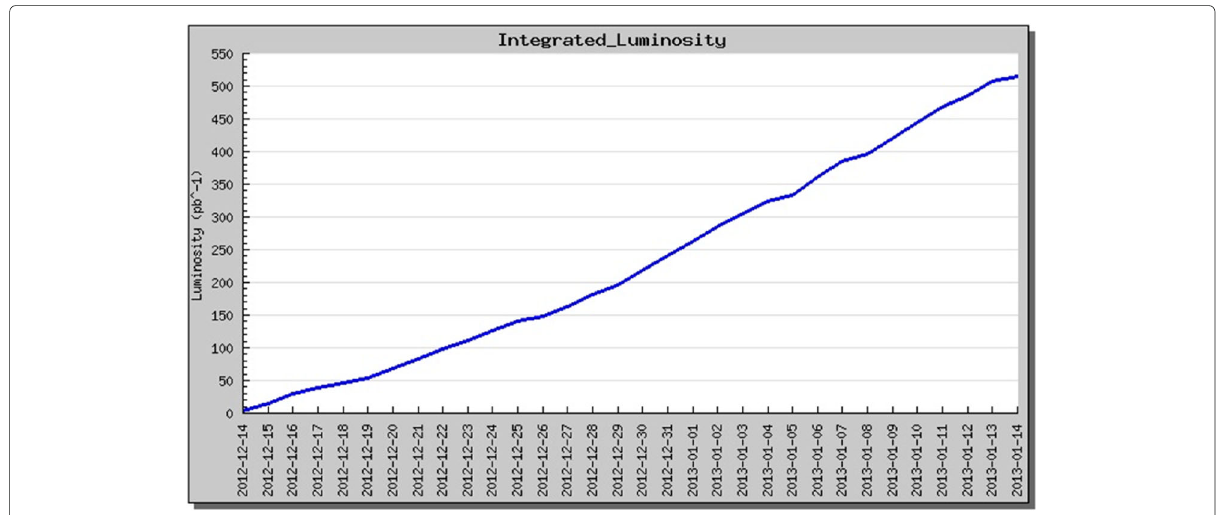
Fig. 3 The integrated luminosity collected by the BESIII detector from December 2012 to January 2013